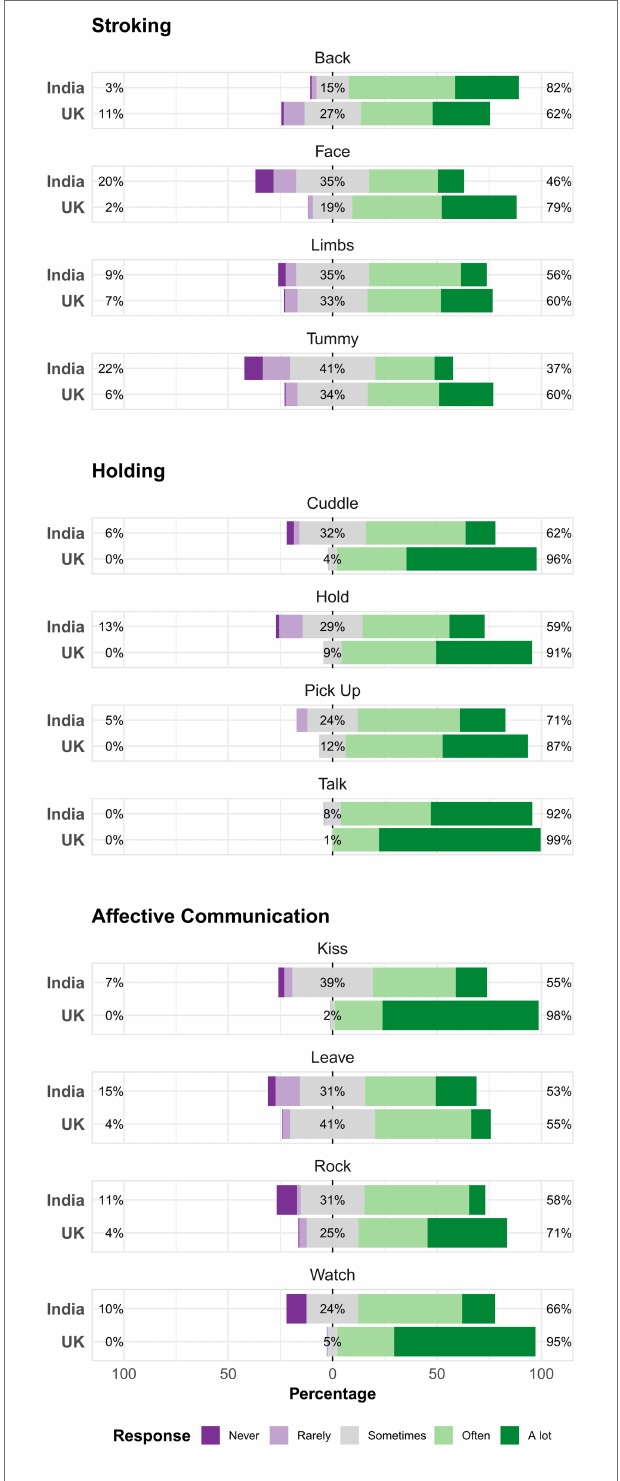
FIGURE 1 | Distribution of responses to PICTS items according to country cohort. The distributions are centered at the middle category “Sometimes.” Percentages are given for the center response, high response (greater than sometimes), and low response (less frequently than